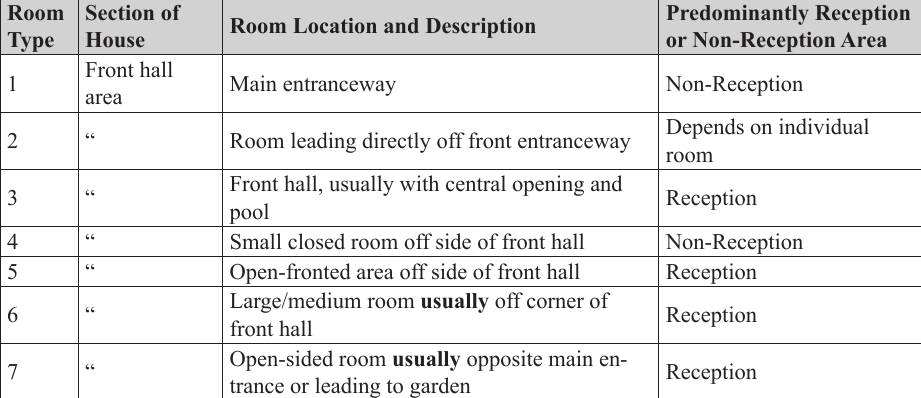
Table 1: Allison’s room type criteria (after Allison 2004a, Table 5.a) with slight adaptations in bold, and the reception level of the room